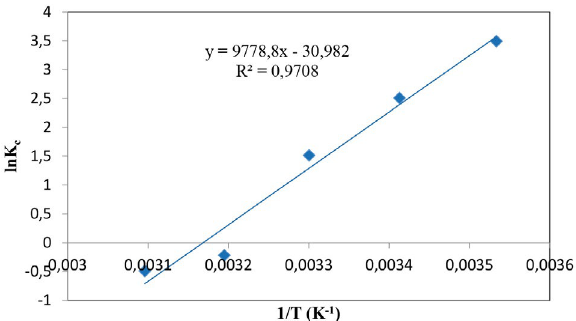
Figure 13. Temperature effect on the sorption of Cr(VI) ions on Isatin based Amberlite XAD-2